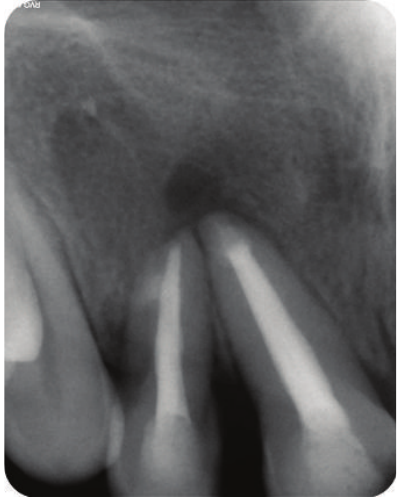
Figure 44: 6-month followup IOPA